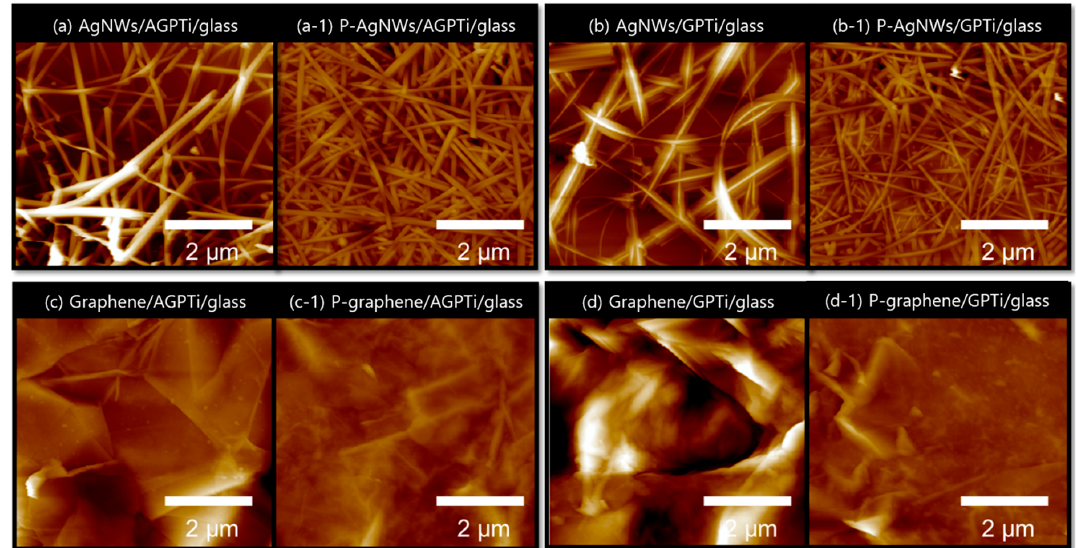
Figure 6. AFM images of the AgNWs and graphene on AGPTi and GPTi before (( a ) AgNWs/AGPTi/glass, ( b ) AgNWs/GPTi/glass, ( c ) graphene/AGPTi/glass, and ( d ) graphene/GPTi/glass), and after (( a-1 ) P-AgNWs/AGPTi/glass, ( b-1 ) P-AgNWs/GPTi/glass, ( c-1 ) P-graphene/AGPTi/glass, and ( d-1 ) P-graphene/GPTi/glass) the mechanical pressing process.